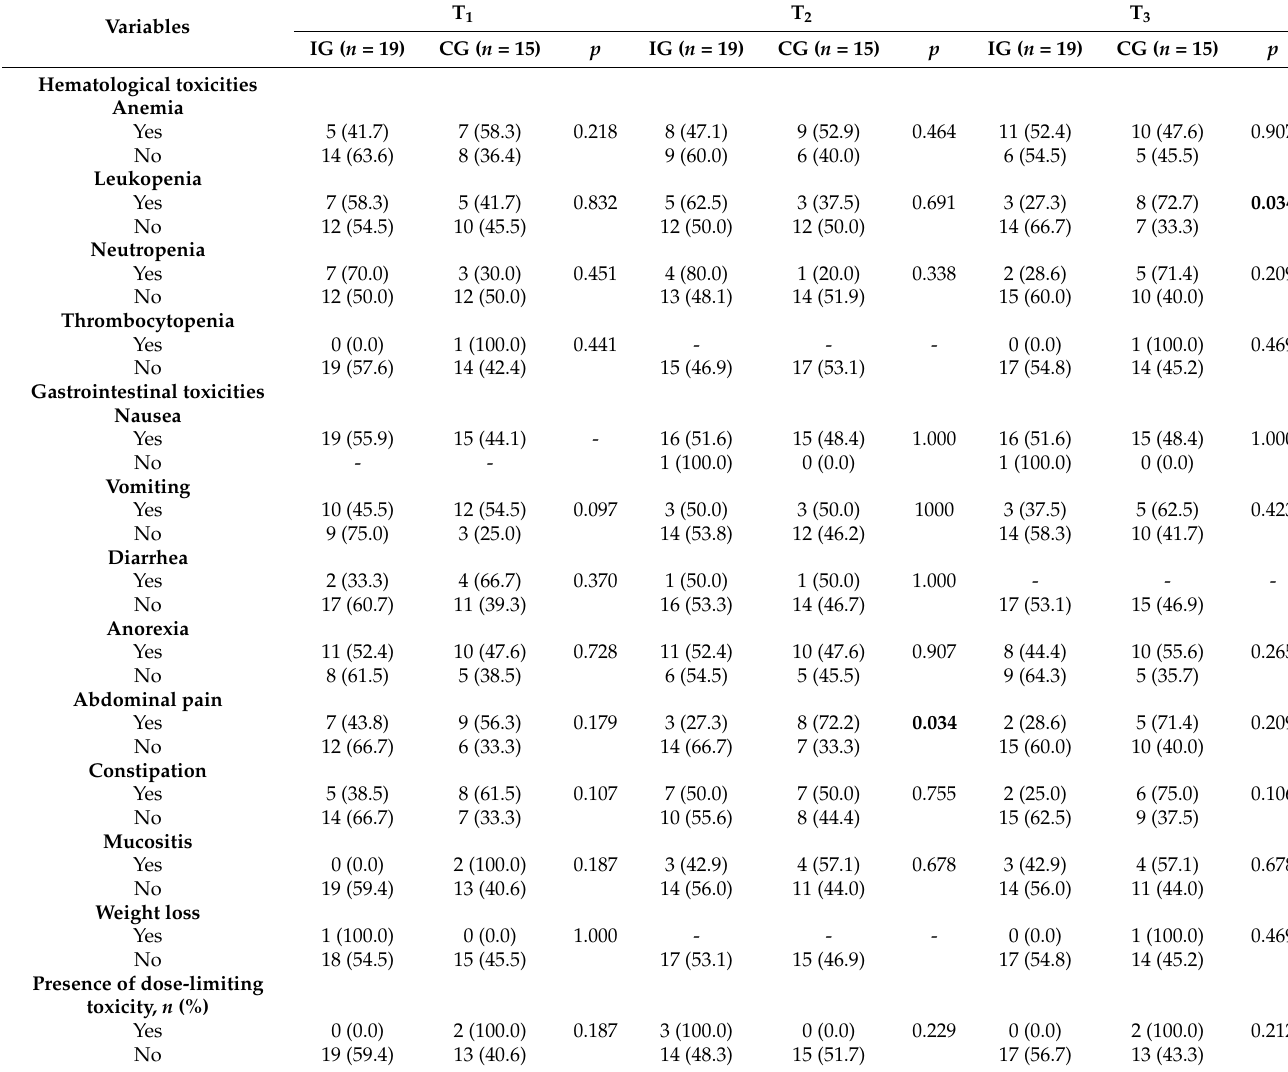
Table 4. Comparison of the frequency of hematological and gastrointestinal toxicities and the presence of dose-limiting toxicity between the intervention and control groups in the first three cycles of neoadjuvant